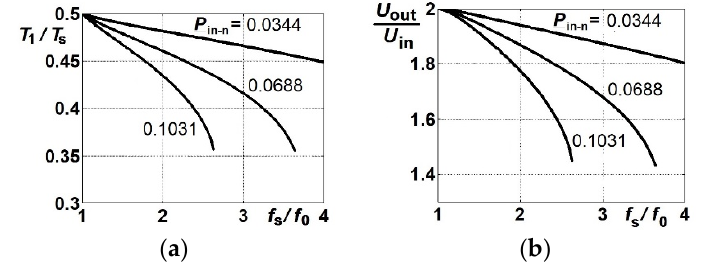
Figure 4. ( a ) Normalized conduction time T 1n = T 1 / T S of transistors, ( b ) normalized output voltage U outn = U out / U in : as a function of f S n = f S / f 0 for three values of normalized power P in-n = P in /( U in2 / ρ ): 0.0344, 0.0688, and 0.1031. Switching pattern P2.